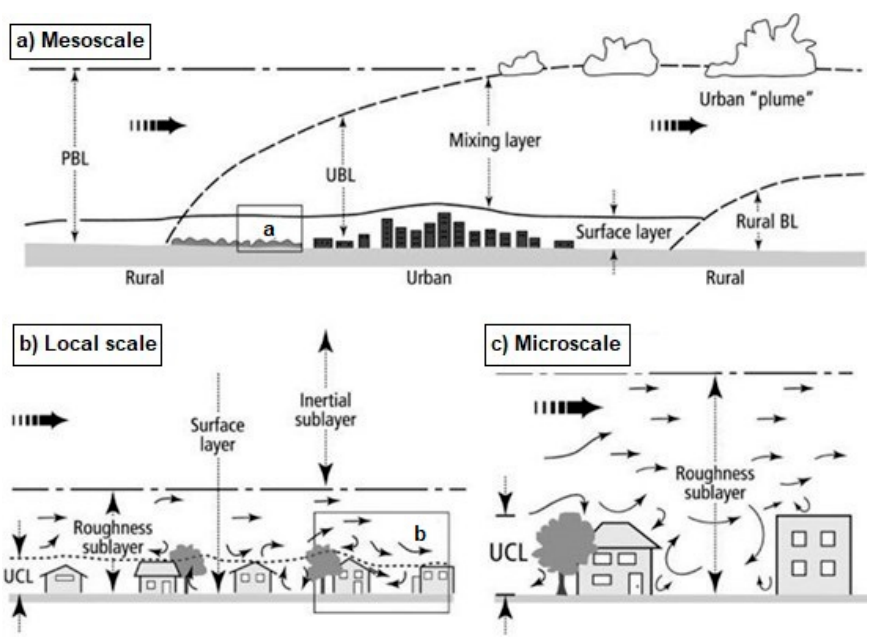
Figure 1. Three scales, mesoscale ( a ), local scale ( b ) and microscale ( c ), used to distinguish atmos- pheric processes in the urban area and the atmospheric layers: planetary boundary layer (PBL), the urban boundary layer (UBL), urban canopy layer (UCL) (Modified after Núñez Peiró et al. ) [39].